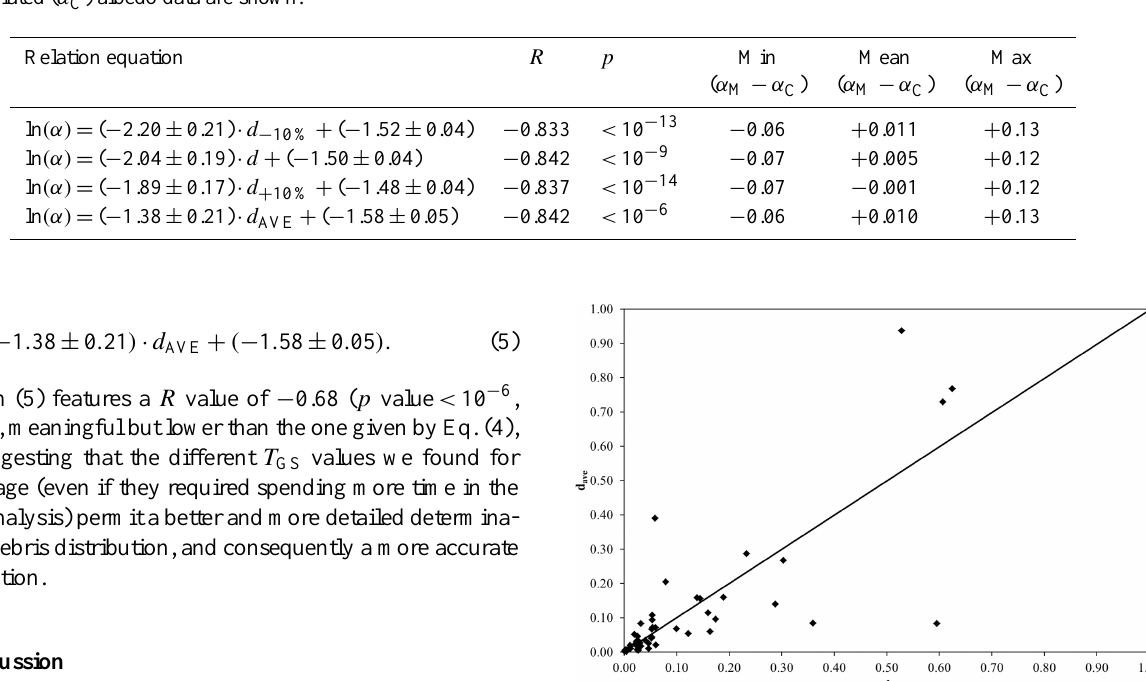
Table 3. Depending on the four different ratio data sets (considering d + 10% , d , d − 10% and d AVE ), the differences between measured ( α M ) and calculated ( α C ) albedo data are shown.